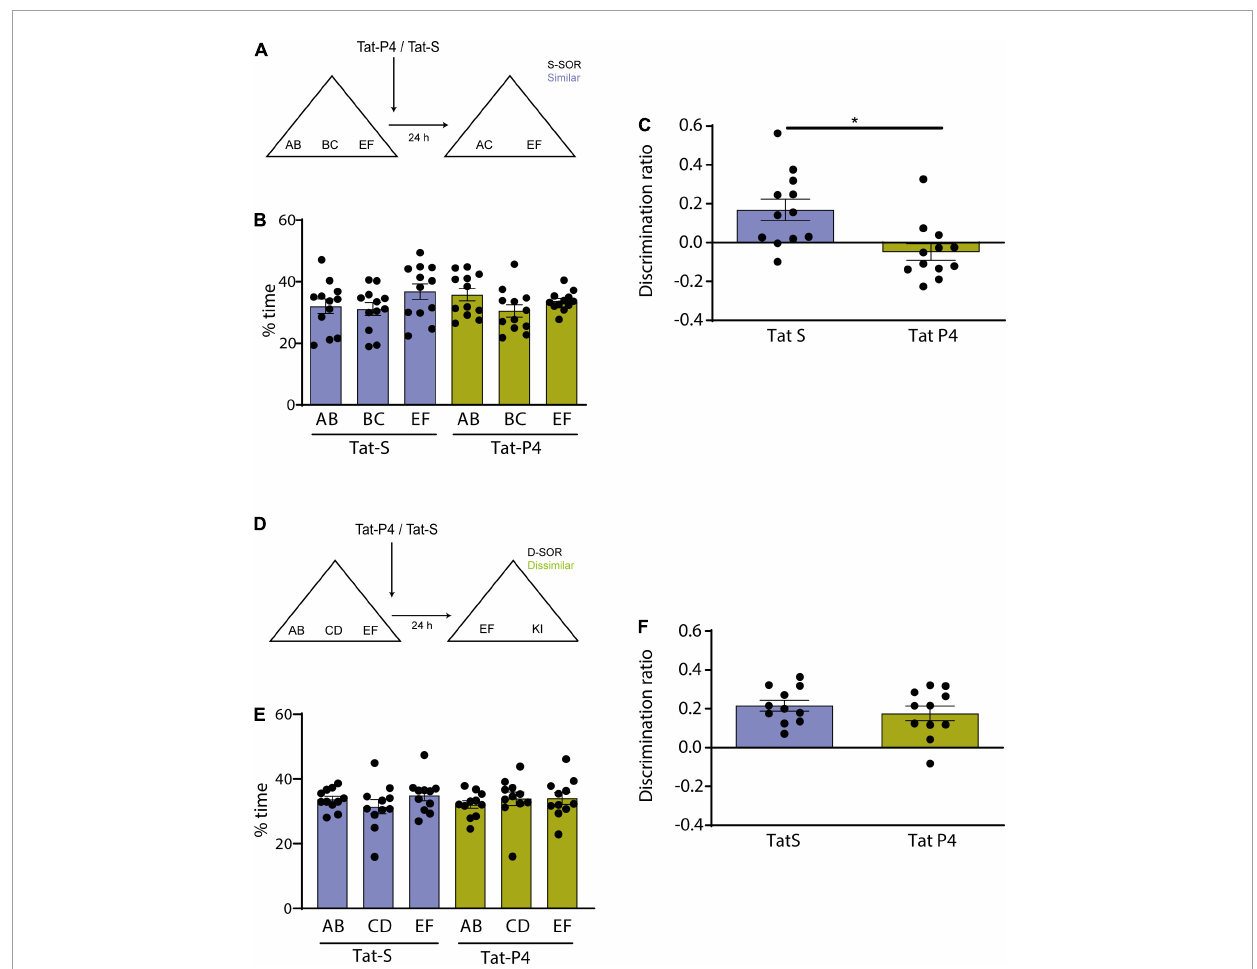
FIGURE2 (A) Schematic illustration of the similar-spontaneous object recognition task (s-SOR) task indicating when Tat-P4/Tat-S was infused. (B) Percentage of time spent exploring each of the objects in the sample phase in the s-SOR. Repeated-measures two-way ANOVA (%time); F = 1.000, pdrug = 0.3388, F = 2.045, pobject = 0.1533, F = 0.7906, pinteraction = 0.4660. (C) Effect of Tat-P4 or Tat-S injections on the discrimination ratios for the s-SOR version of the task. Paired t -test ( t = 2.899), p = 0.0145, n = 12. (D) Schematic illustration of the dissimilar (d-SOR) task